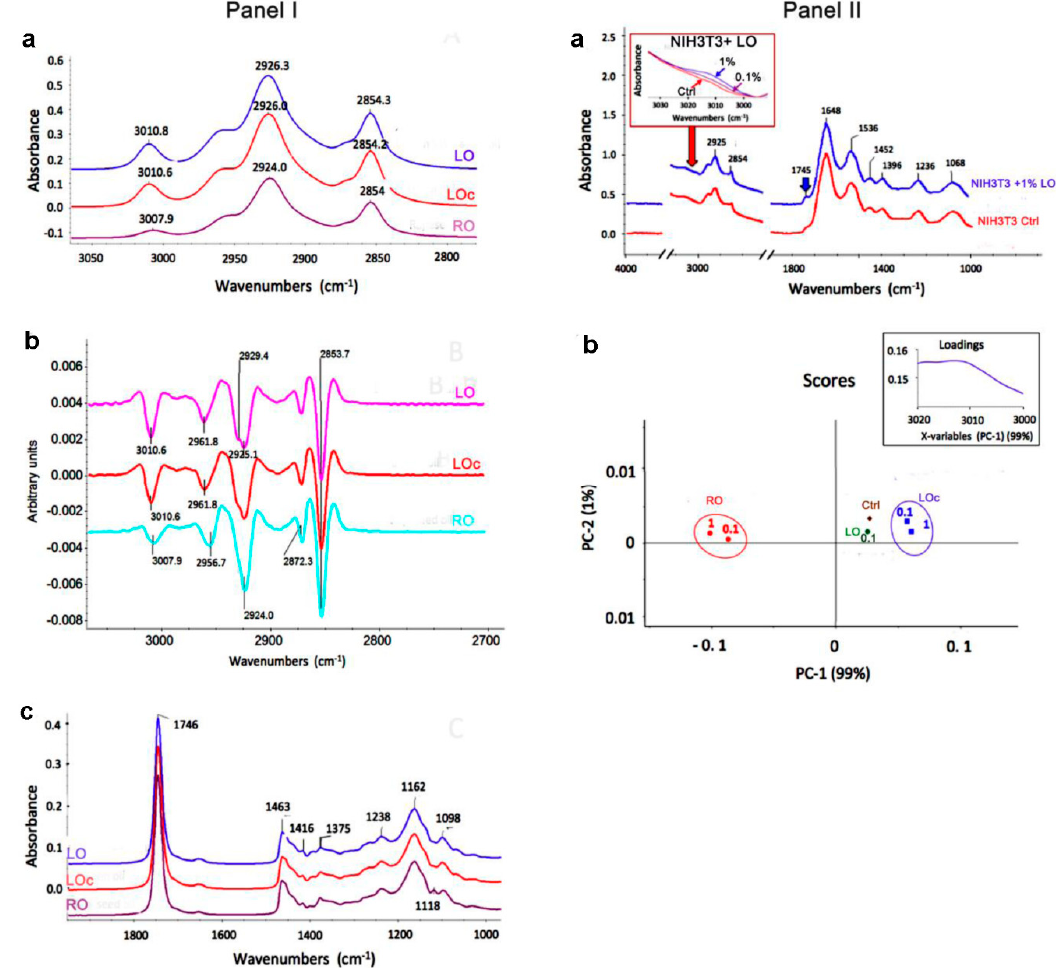
Figure 1. Chemical characteristics of oils using FTIR spectroscopy. Panel I : ATR-FTIR spectra of vegetable oils added to culture medium. ( a ) The spectra within the region between 3050 and 2800 cm − 1 characteristic for alkene (above 3000 cm − 1 ) and alkane (below 3000 cm − 1 ) fatty acid chains; ( b ) The second derivatives of the oil spectra used for precise location of the absorbance peaks; ( c ) The spectra in the region of (C=O) stretching vibrations of ester group from lipids and in the fingerprint region (1500–1000 cm − 1 ). Panel II : ( a ) ATR-FTIR spectra of LO-treated cells. Positions of major bands are shown. Bands related to fatty acid functional groups including olefinic (C-H) stretching absorbance in the region characteristic for unsaturated fatty acids and C=O stretching vibrations for esters characteristic for lipid compounds are denoted using red and blue arrows, respectively. The FTIR spectra in the region of =C-H bonds reflecting the presence of unsaturated acids within the cells are enlarged and shown within a red frame. The spectra were base-corrected and normalized to amide I peak at 1648 cm − 1 ; ( b ) PCA two-dimensional score plot of FTIR spectra for principle components (PA) 1 and 2 in the region of unsaturated fatty acids (3200–3000 cm − 1 ) derived from oil-treated cells. Oil-dependent and concentration-independent effects are observed. Corresponding loading values are shown in a black frame. LO, linseed oil (VIS NATURA); LO c , linseed oil (DARY NATURY); RO, rapeseed oil.